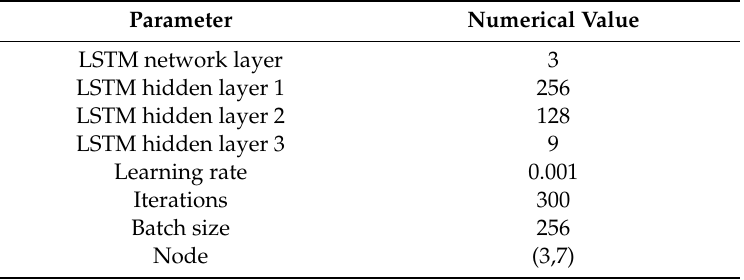
Table 6. LSTM network parameters.